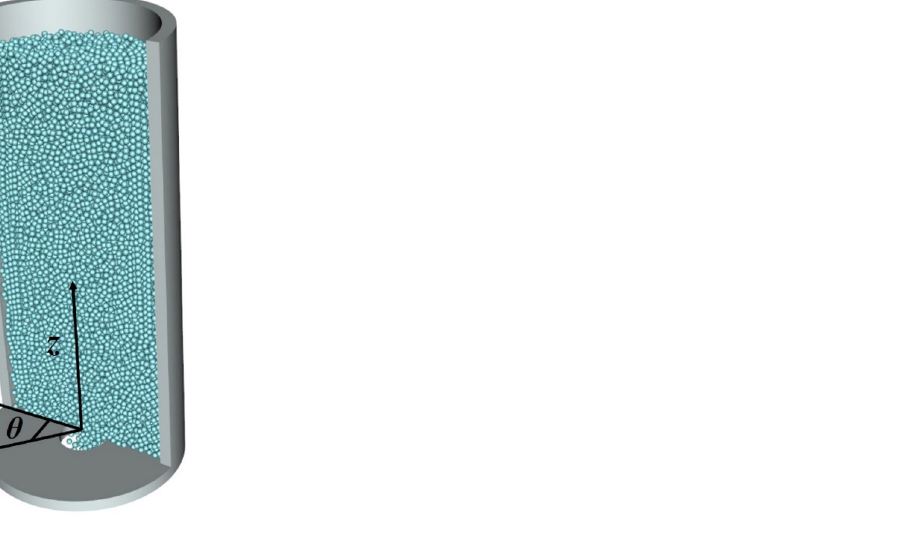
Figure 1. Simulation system with a cylindrical coordinates system. The origin is set at the center of the